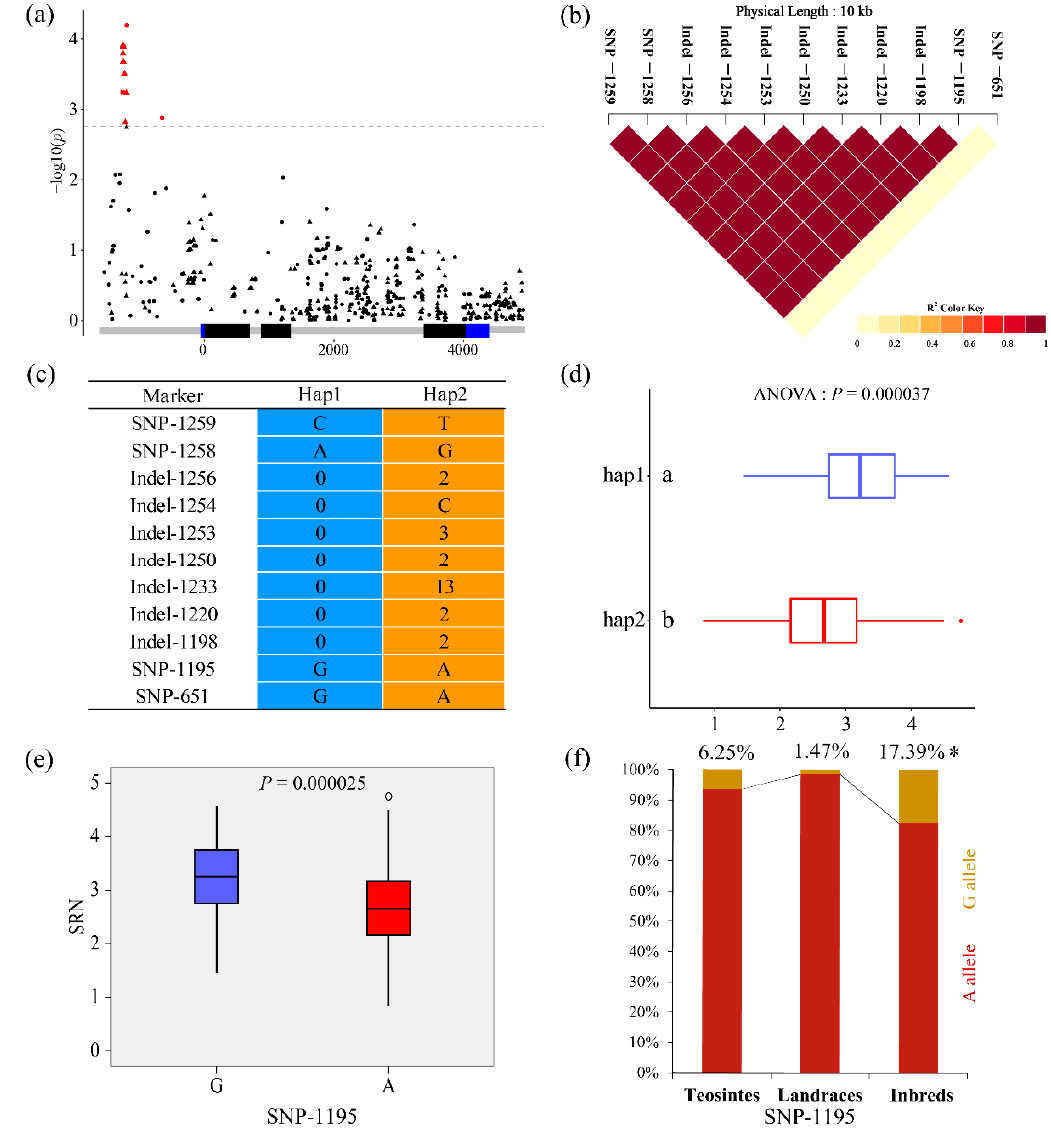
Figure 3. The natural variation of ZmCKX5 was significantly associated with the seed root number (SRN). ( a ) Trait–marker association between ZmCKX5 and SRN; ( b ) LD heatmap of 11 variants significantly associated with SRN; ( c ) Haplotypes of ZmCKX5 among natural variations in inbred lines; ( d ) Comparison of seminal root number between different haplotypes; ( e ) Comparison of seminal root number between different alleles of single-nucleotide polymorphism (SNP)-1195; ( f ) The allele frequency of SNP-1195 in teosintes, landrace, and inbred lines. * indicated a significance different in allele frequency between different group at p < 0.05 level by chi-square test.